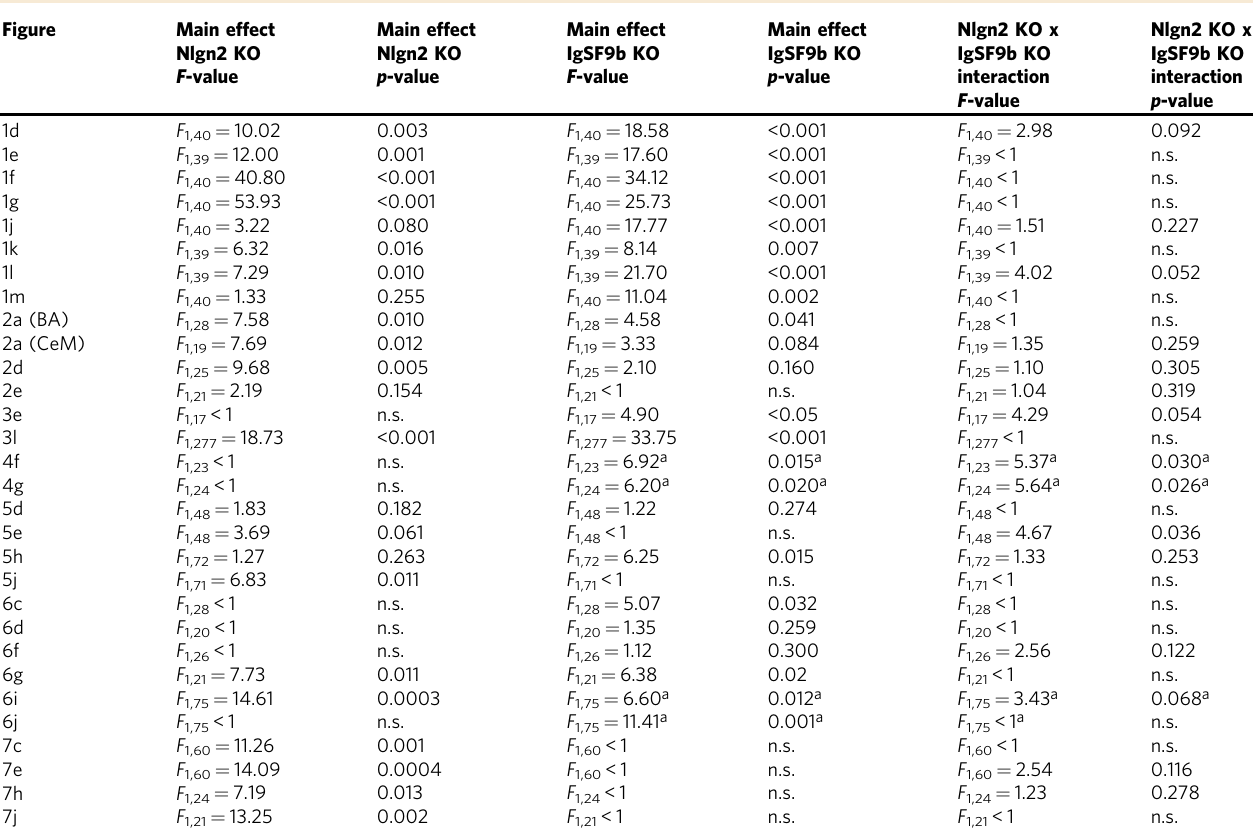
Table 1 Two-way ANOVA comparisons